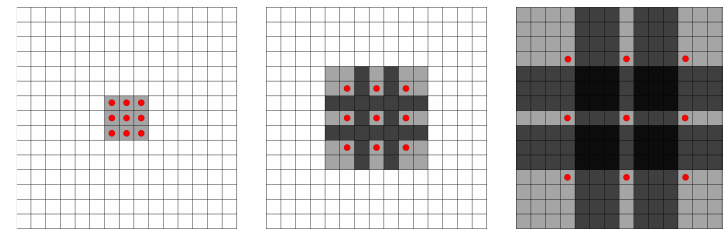
Figure 3. Dilated